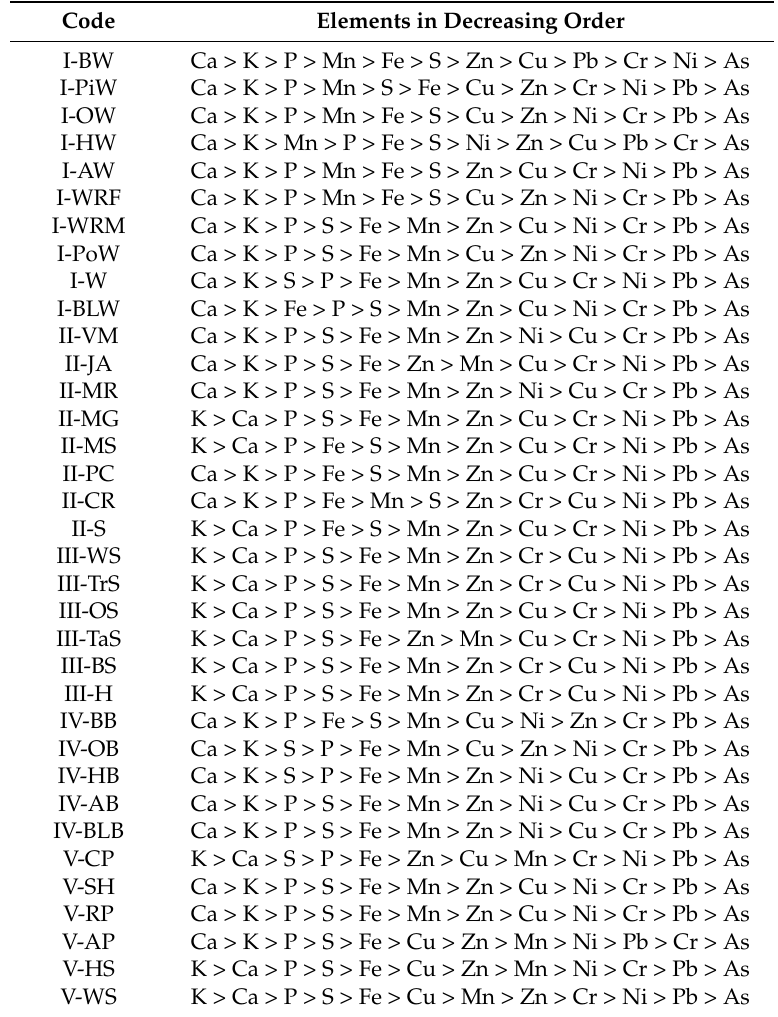
Table 3. The analyzed elements ranked by decreasing content in the examined ashes. Code Elements in Decreasing